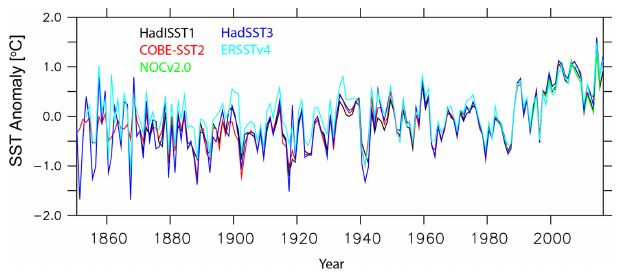
Figure 34. Sea surface temperature anomaly in the greater North Sea region from 1870 to 2016 (relative to the mean 1971 to 2000), according to different datasets. Data source: Huthnance et al., 2016; updated by Elizabeth Kent, Southampton,